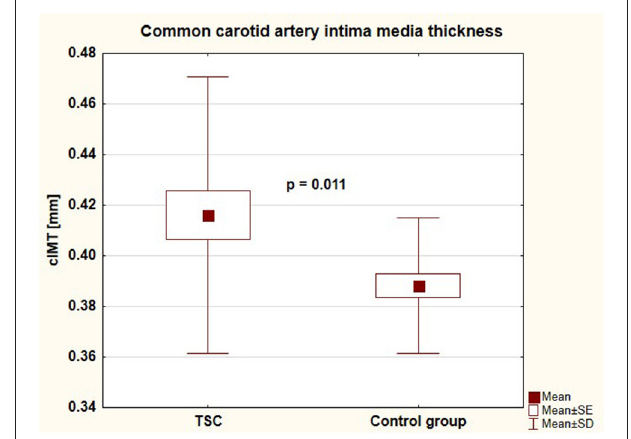
FIGURE 4 | Aortic systolic blood pressure in children with tuberous sclerosis complex and in control group (AoSBP, aortic systolic blood pressure; TSC, tuberous sclerosis complex; SE, standard error; SD, standard deviation).